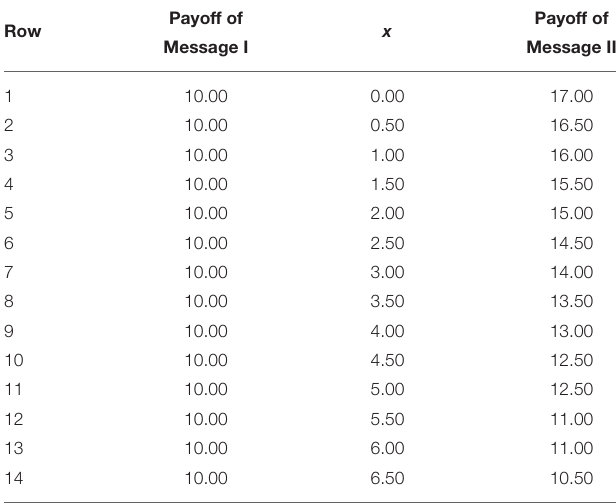
TABLE 2 | Senders’ choice lists (amounts in